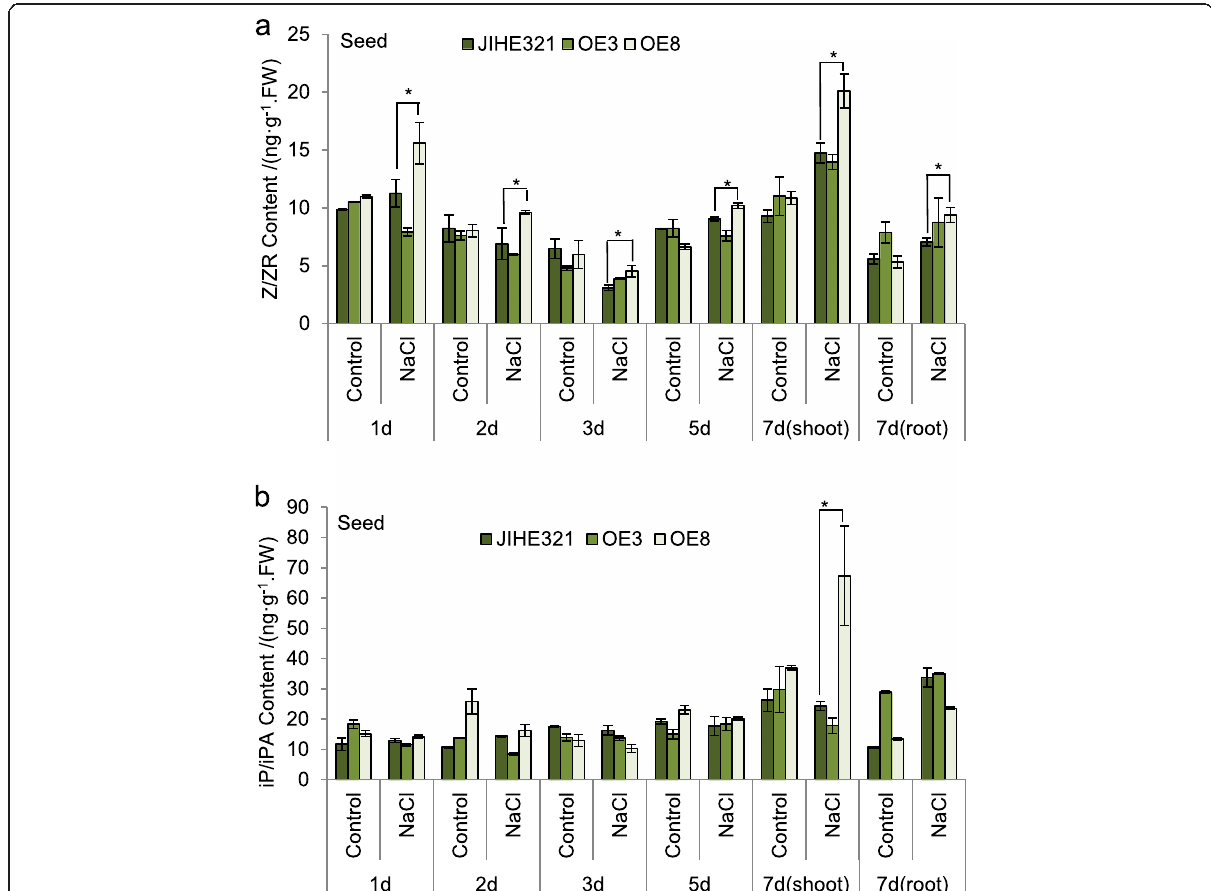
Fig. 3 Ectopic-expression of SAG12::IPT induces cytokinin content in cotton seeds. a Ectopic expression of SAG12::IPT induces Z/ZR-type cytokinin content in seeds of the OE3 and OE8 lines. Germinating seeds (0.5 g, without the seed coat) were sampled after one, two, three, and five days of germination; shoots and roots (0.5 g) separated from the germinating seeds with 220 mmol·L − 1 NaCl treatment for seven days were collected to detect the Z/ZR-type cytokinin content. b Ectopic expression of SAG12::IPT induces iP/iPA-type cytokinin content in seeds of OE3 and OE8. The samples from ( a ) were used for the measurement of iP/iPA-type cytokinin. The data are shown as means ± SD from three repeats ( n = 3, * P ≤